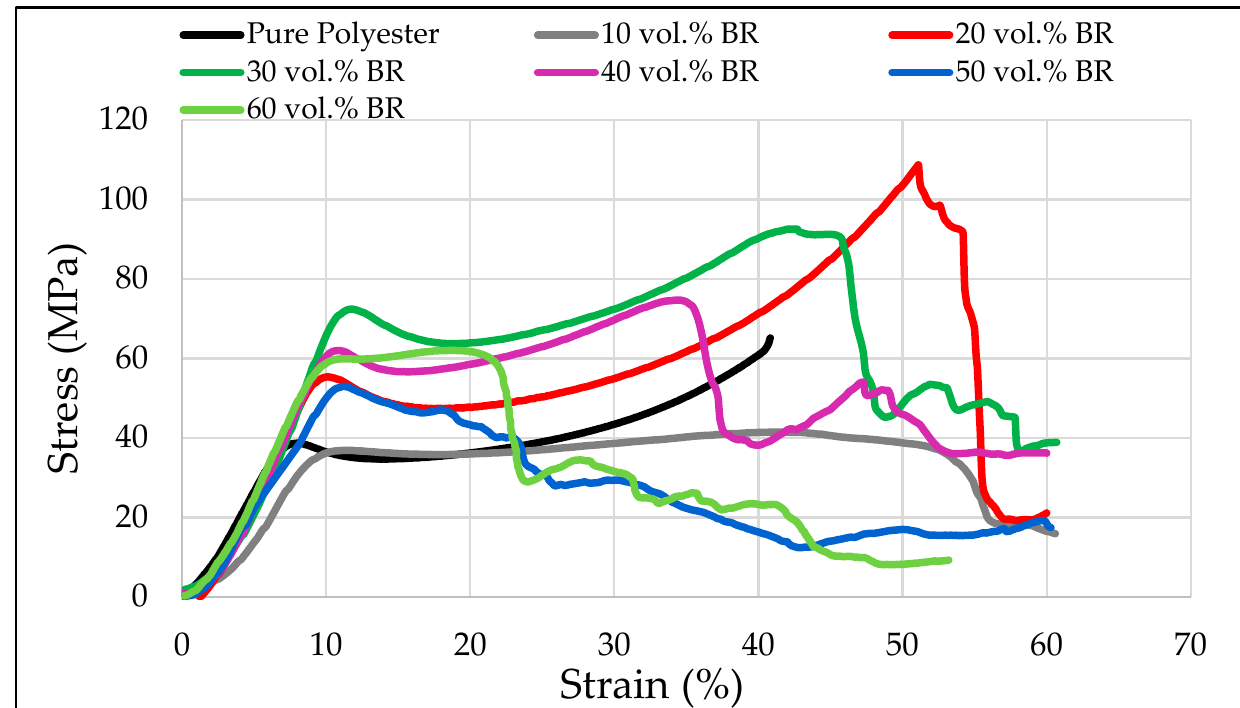
Figure 4. Compressive stress–strain curves of BR–UPR composites. Table 3. Compressive, tensile, and flexure mechanical properties of BR–UPR composites.